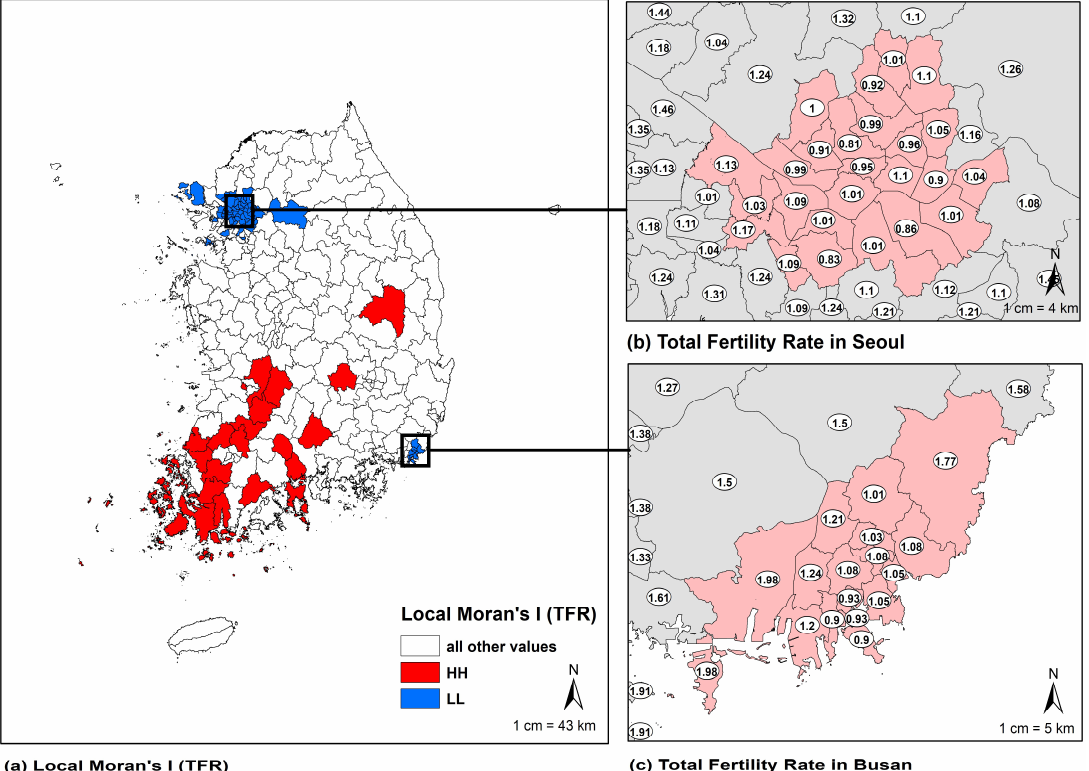
Figure 2. ( a ) Local Moran’s I of local TFRs; ( b ) TFRs in Seoul; ( c ) TFRs in Busan.